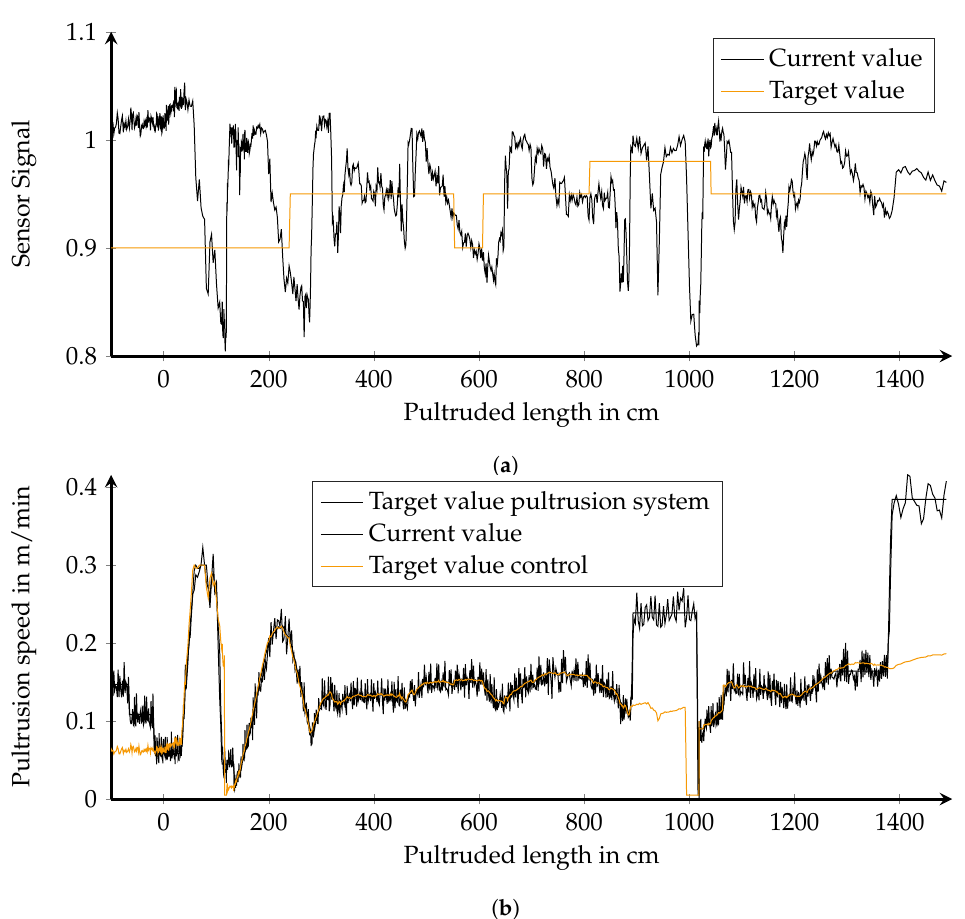
Figure 7. Experimental results of the pultrusion control unit for a pultrusion at 140 ◦ Cover the length of the pultruded material. ( a ) Sensor signal; ( b ) pultrusion speed.